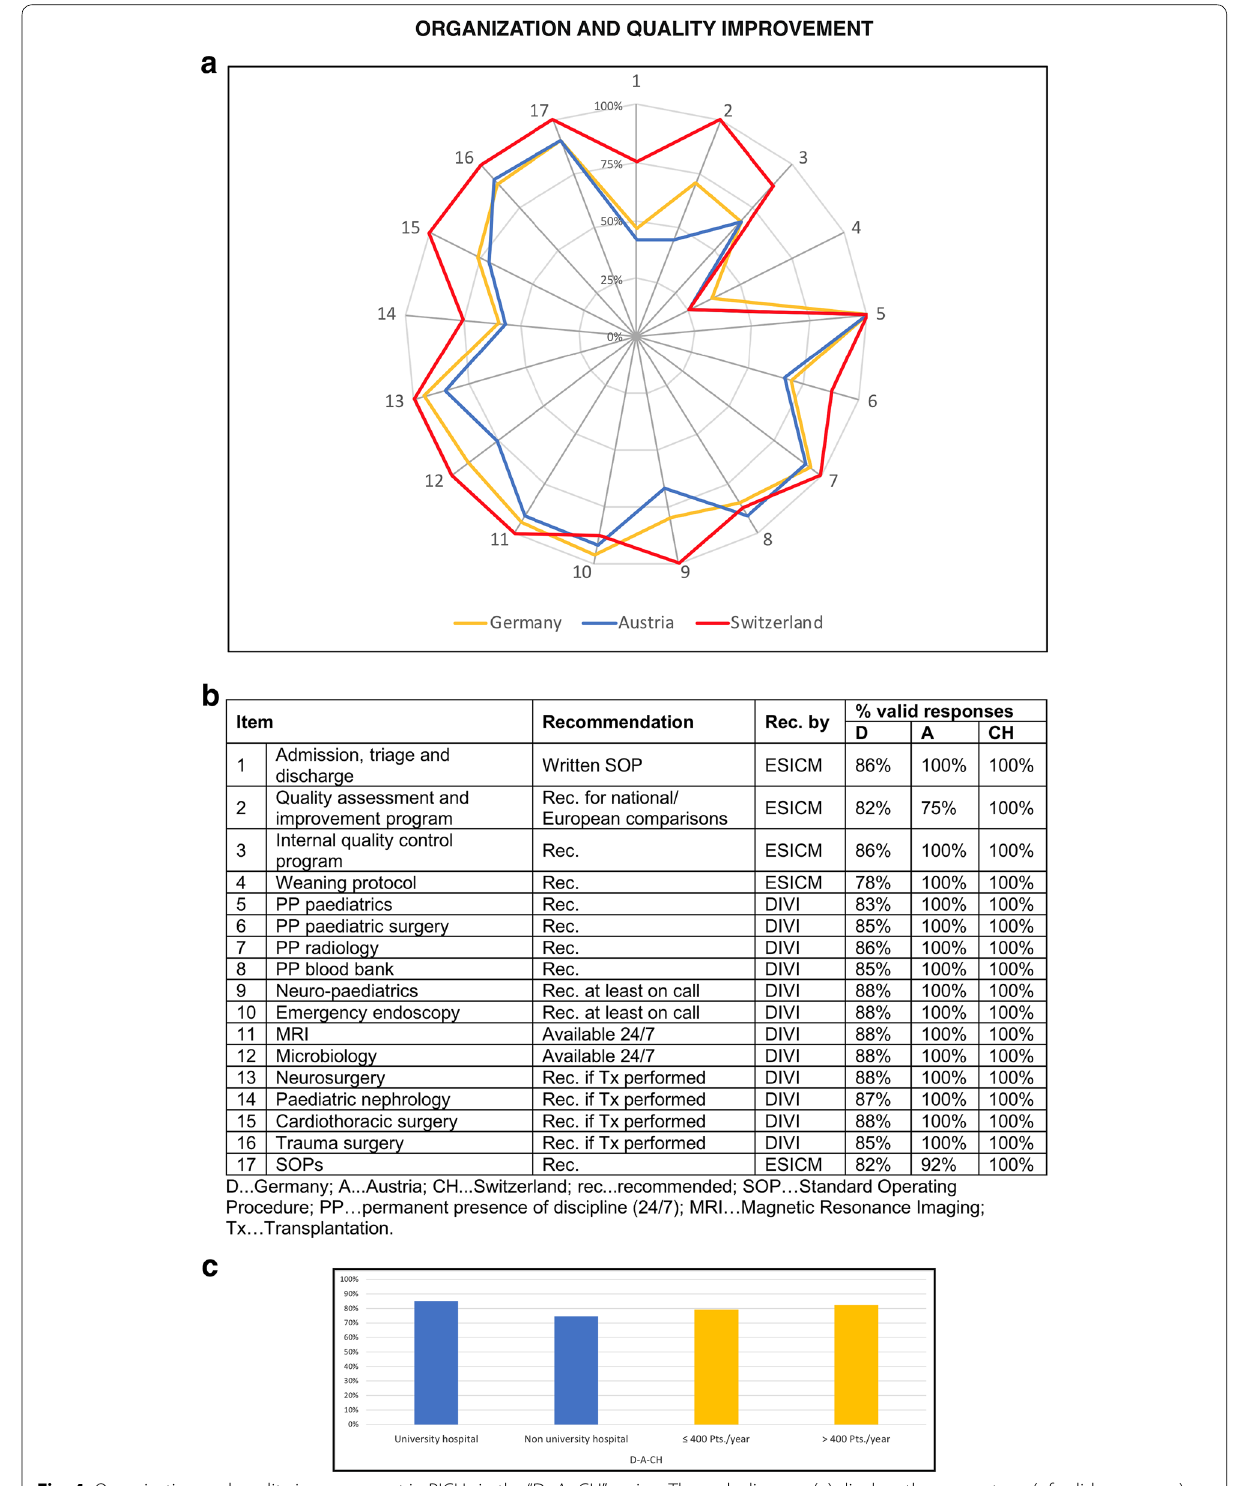
Fig. 4 Organization and quality improvement in PICUs in the “D–A–CH” region. The web diagram ( a ) displays the percentage (of valid responses) of PICUs, meeting the recommendations for the different items surveyed. In the table ( b ), the valid response rates for the different items are listed. The bar charts ( c ) display the mean of all 17 items concerning organization and quality improvement according to the sub-categories university/ non-university hospital and 400/> 400 patients treated ≤